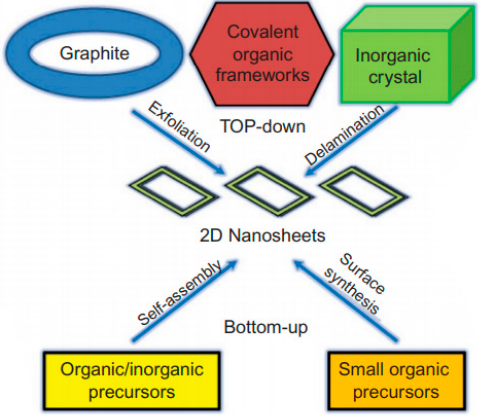
Figure 3. Schematic illustration of top-down and bottom-up strategies toward the synthesis of 2D nanosheets. (Reprinted with permission from [41]. Copyright (2015), Elsevier.)